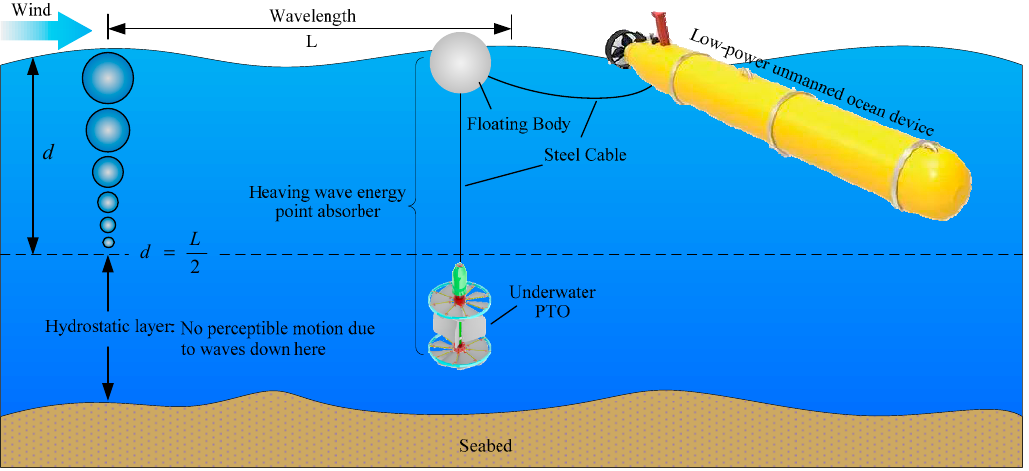
Figure 1. The working scene of the novel heaving wave energy point absorber.